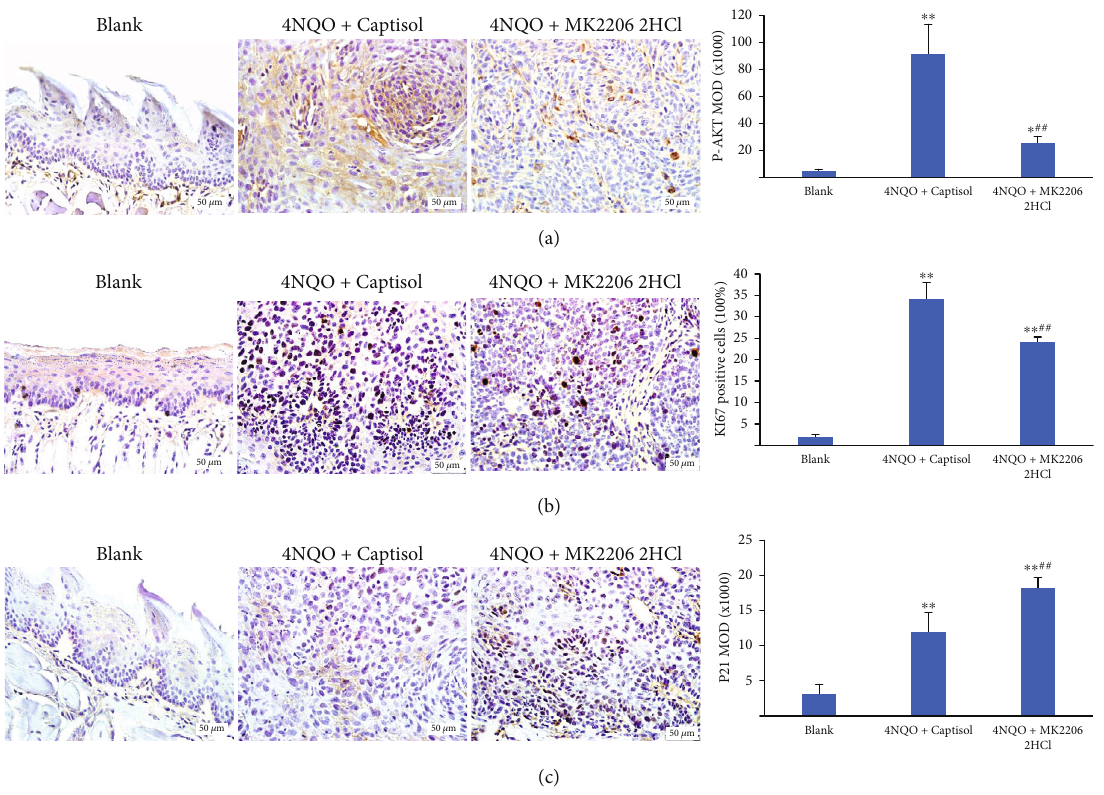
Figure 4: MK2206 2HCl suppressed cancer cell proliferation in 4NQO-induced mouse tongue tumors. (a) MK2206 2HCl inhibited p-AKT expression in 4NQO-induced mouse tongue tumors. (b) Cell proliferation was suppressed by MK2206 2HCl as showed by Ki67 positive cells. (c) MK2206 2HCl promoted p21 expression in tongue tumors. All data are presented as the mean ± SD : ∗∗ P < 0 : 01, ∗ P < 0 : 05 as compared with the blank group, ## P < 0 : 01 as compared with the 4NQO+captisol group. Magni fi cation ×